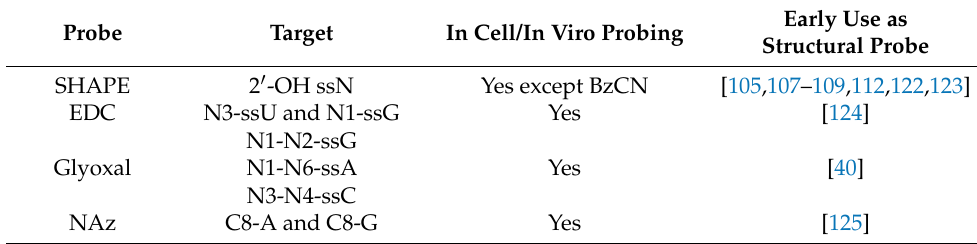
Table 2. SHAPE and post-SHAPE chemical